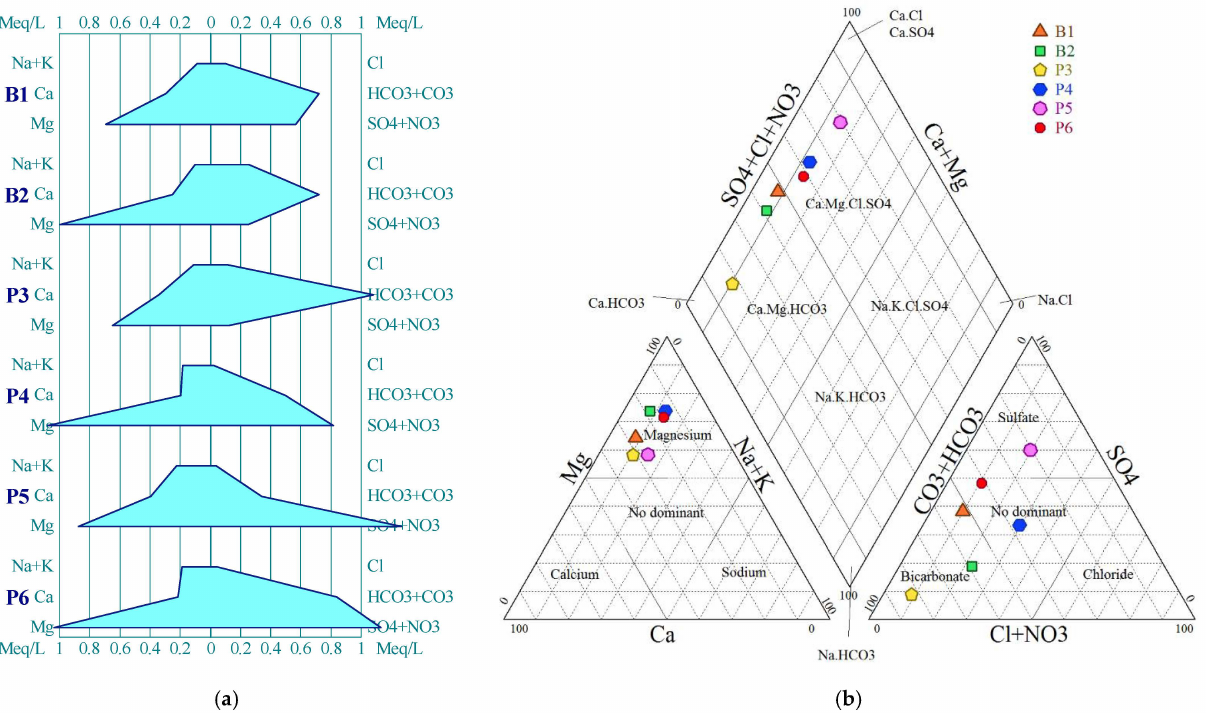
Figure 3. Stiff ( a ) and Piper ( b ) diagrams showing the classification of the water type of the shallow